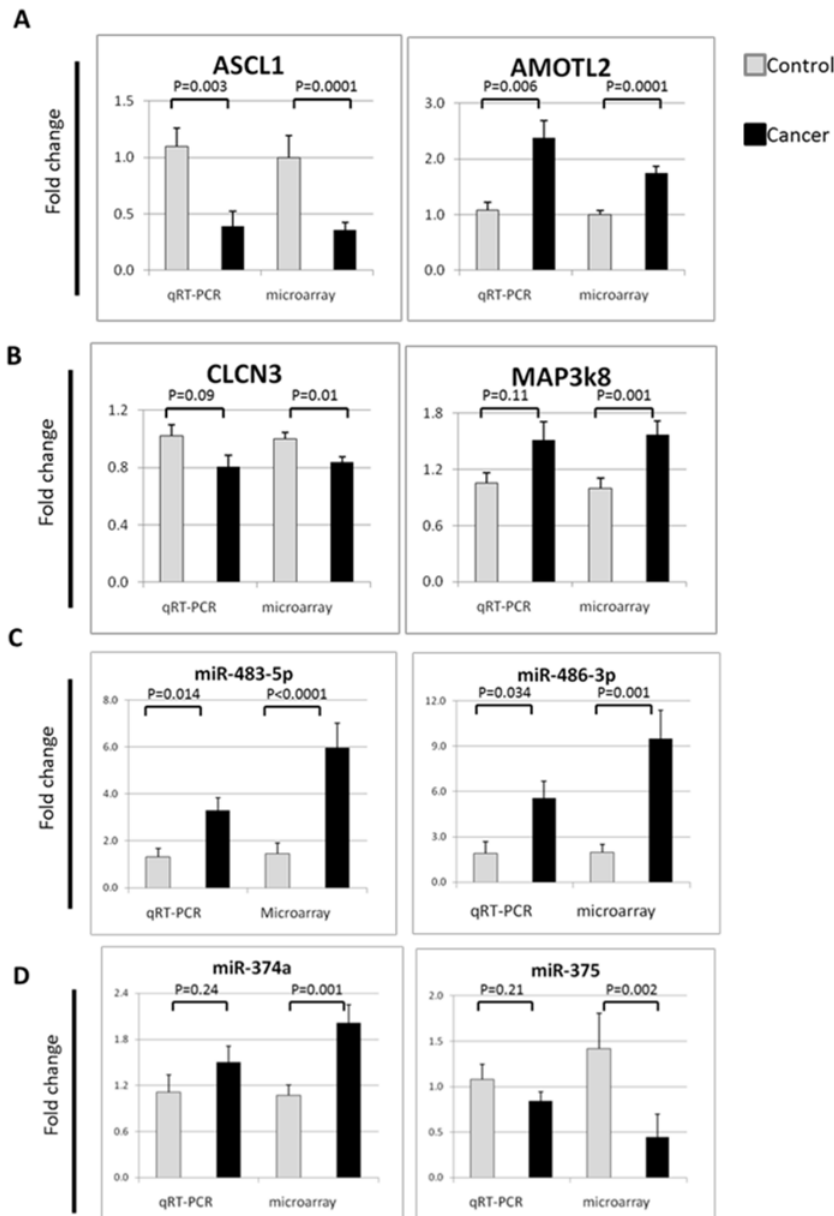
Fig 2. Real time RT-PCR validation. A) Two highly significant differentially expressed genes (ASCL1 and AMOTL2) detected by microarray in the peripheral airway epithelial cells of cancer patients compare to smokers controls, were confirmed with RT-PCR, producing similar p-value and fold change. B) Two randomly selected genes (CLCN3 and MAP3k8) were confirmed with RT-PCR to produce fold change in same direction and with similar magnitude to that seen with microarray. Gene expressions were expressed as means and ± standard errors of means. C-D) Three up-regulated miRNA and a fourth down-regulated miRNA were select for RT-PCR to confirmation miRNA expression. miR-486 – 3p, miR-483 – 5p, and miR-374a were up-regulated and miR-375 was down-regulated in the peripheral airway field of cancerization in lung cancer patients compared to smoker controls; fold change between cancer patients and smoker controls were in the similar direction. MiRNA expressions were expressed as means and ± standard errors of means.